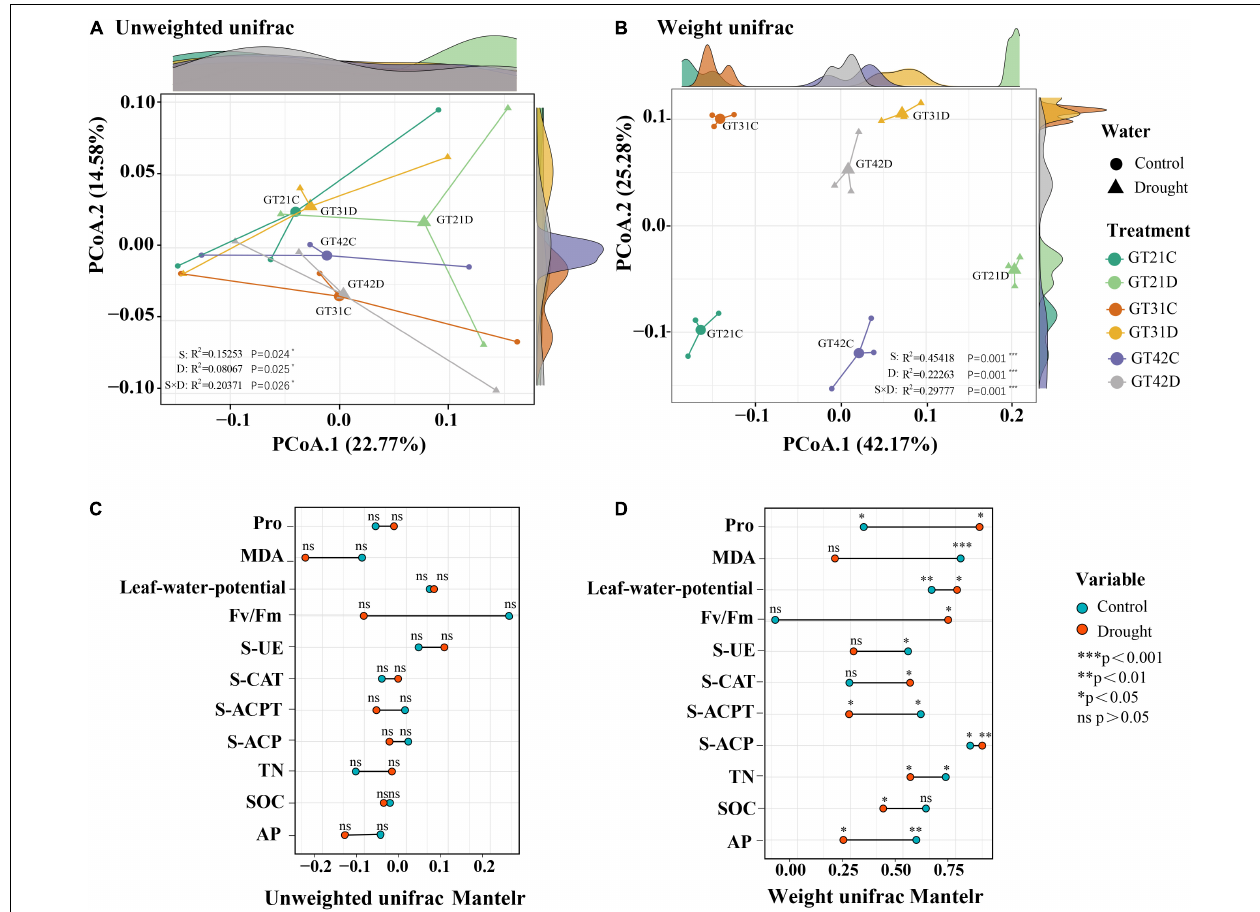
FIGURE 2 | Beta diversity analysis revealed similarities in bacterial community composition between different treatments. The principal coordinate analysis based on unweighted Unifrac distance (A) and the principal coordinate analysis based on weighted Unifrac distance (B) for bacterial community composition among different treatments. Axis.1 represents the contribution rate of water treatment to differences among treatments, and Axis.2 represents the contribution rate of varieties to differences among treatments. Correlation between environmental factors and phylogenetic members and composition of sugarcane was analyzed using the Mantel